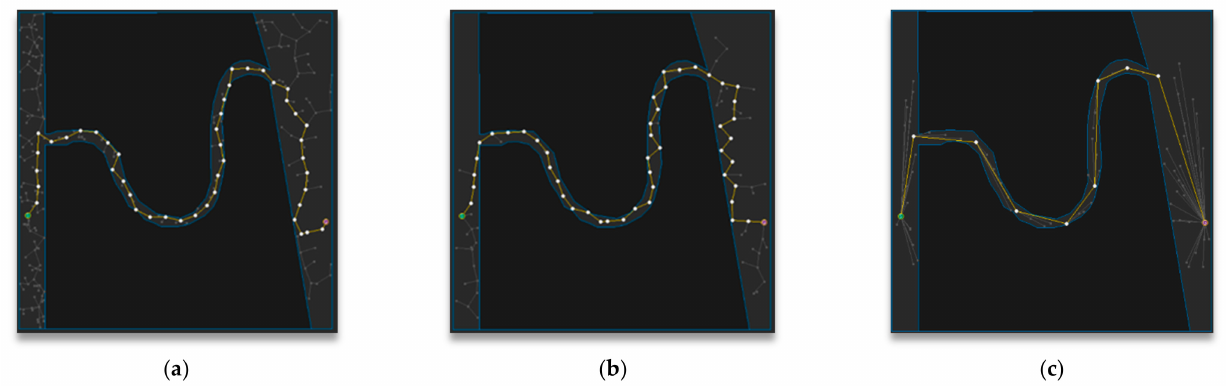
Figure 11. Experimental result of Map 1: ( a ) RRT; ( b ) RRT-Connect; ( c ) the proposed algorithm.